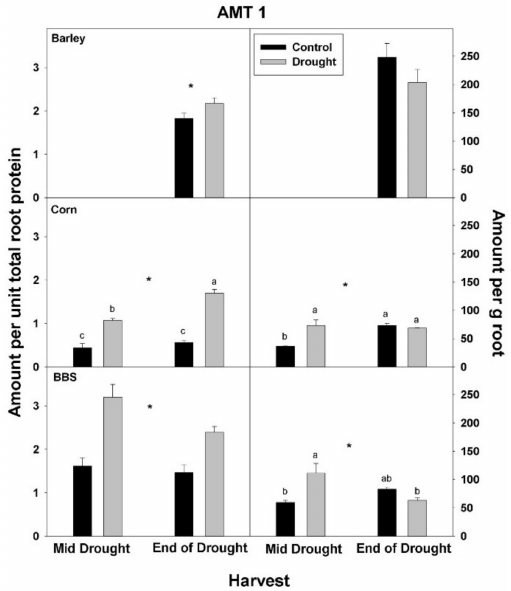
Figure 6. Effects of control vs. drought treatments on the concentration of the ammonium-uptake protein, AMT1, of roots in barley, corn, and big bluestem (BBS). Each bar represents mean + 1 SE (standard error). Within each panel, bars not sharing the same letters are significantly different. For each response variable, significant effects of drought (ANOVA), across both harvest in corn and big bluestem, are indicated with an asterisk (*).